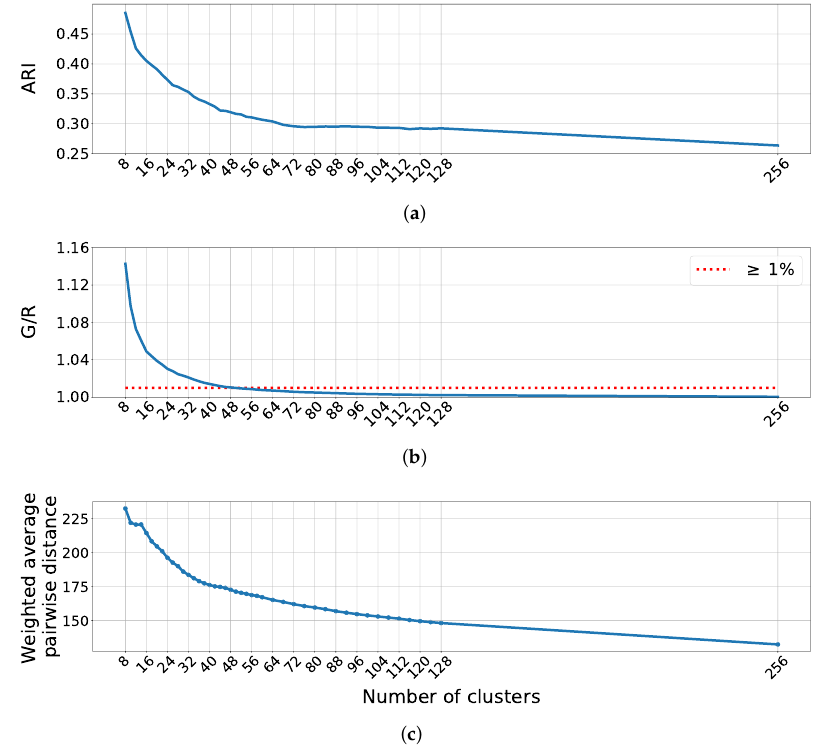
Figure 3. Plots for the first three stability criteria metrics of Table 4, each as a function of the number of clusters. ( a ) Clustering similarity : Adjusted Rand Index (ARI) as a measure of similarity of clusterings generated by RICC models trained on different subsets of patches. ( b ) Clustering similarity significance : The blue line represents the ratio of the mean Rand Index based on RICC applied to our holdout patches { x | x ∈ H } (G) to the mean Rand Index from HAC applied to random uniform distributions (R). The red dashed line is G/R ≥ 1.01, indicating that the stability of cluster label assignments produced from RICC is ≥ 1% better than results of simply clustering random uniform data. ( c ) Intra- cluster texture similarity : The blue line shows the weighted average of the mean squared Euclidean distance between pairs of patches within each cluster. Lower values suggest more homogeneous textures and physical features within each cluster. The use of three similarity tests allows for achieving both stability and maximality criteria when grouping clusters.